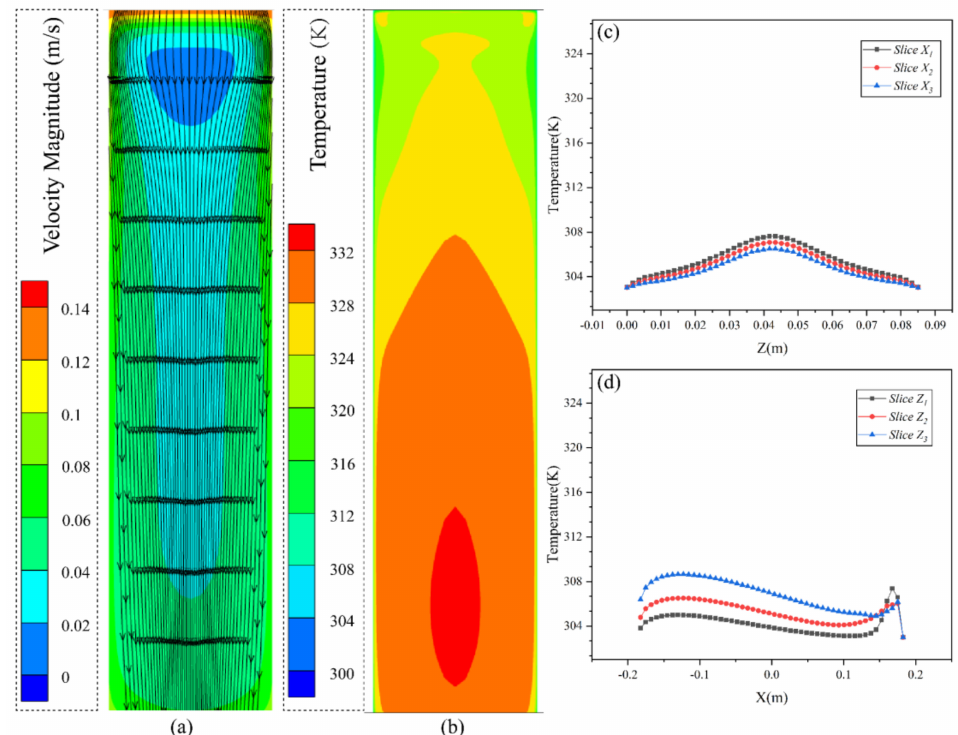
Figure 5. Diagrams of smooth channel under steady state conditions: ( a ) streamline diagram, ( b ) contour diagram of temperature, ( c ) slice temperature diagram in X direction, ( d ) slice temperature diagram in Z direction.